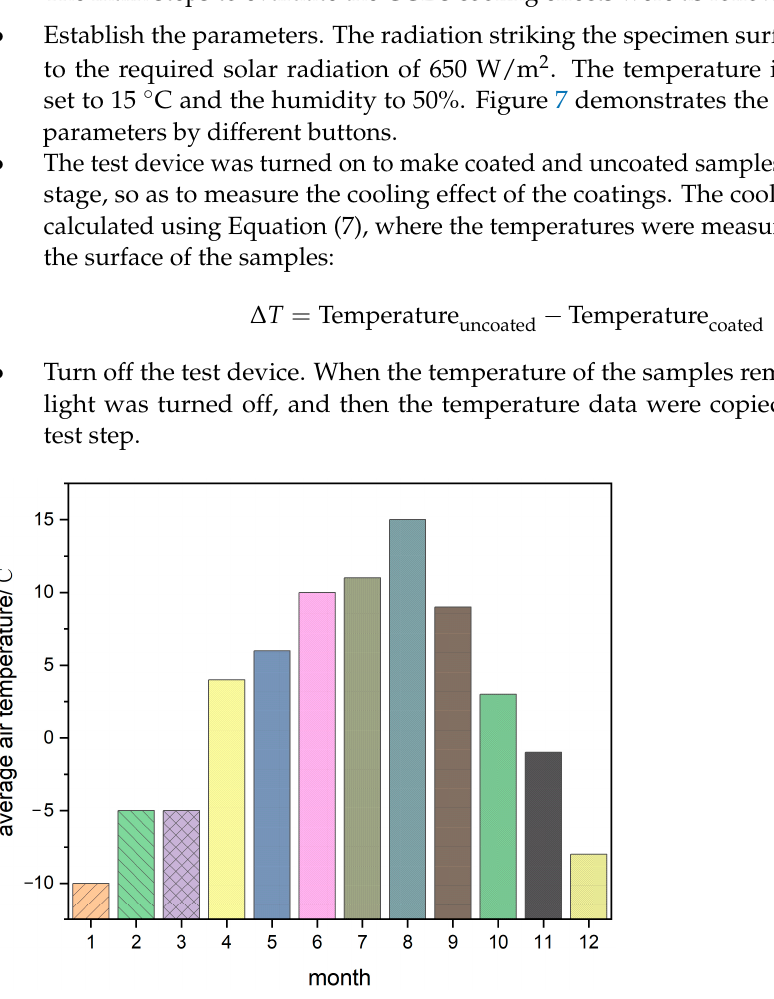
Figure 6. Everyday highest temperature (°C) in August.